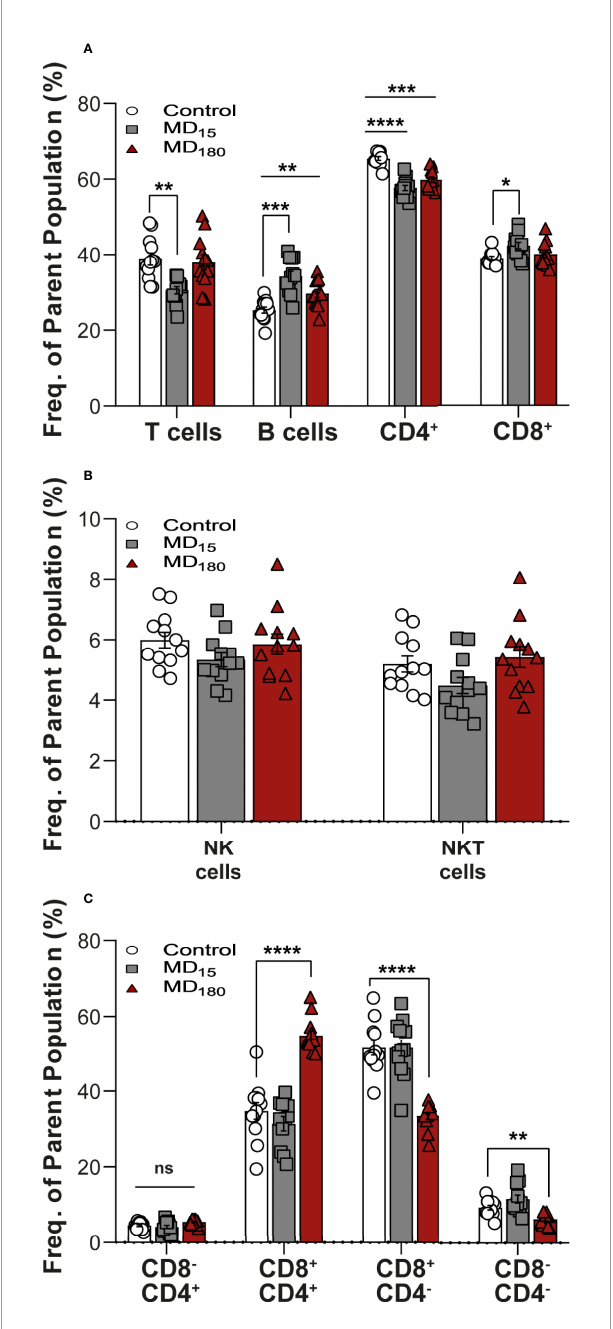
The cytotoxic capacity of rat NK cells after MD was measured against the mouse target cell line YAC-1, as previously described in the literature (84). Cells from animals that underwent 3 hours of MD exhibited a signi fi cantly decreased cytotoxicity from E:T ratio 12.5:1 (5.94 ± 0.38, Dunnett ’ s multiple comparisons test, p=0.0032) to the highest E:T ratio, 100:1 (16.57 ± 1.77, p=0.0057), when compared to the cells of the group that did not suffer any type of early stress (12.99 ± 1.03; 38.16 ± 3.48) ( Figure 4B ). Animals that were maternal separated for 15 minutes displayed a similar response to the control group.